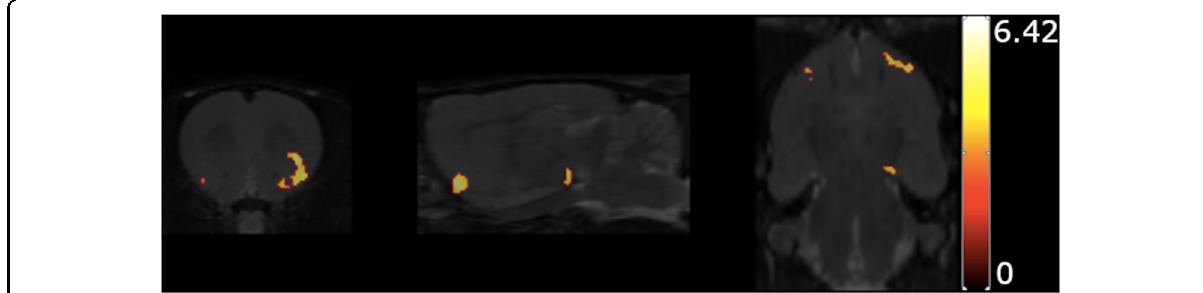
Fig. 5 Results of the voxel-wise comparison of the 5-HT 2A R binding between the rats of the control group (H0/M0) and the rats treated with haloperidol at 0.25